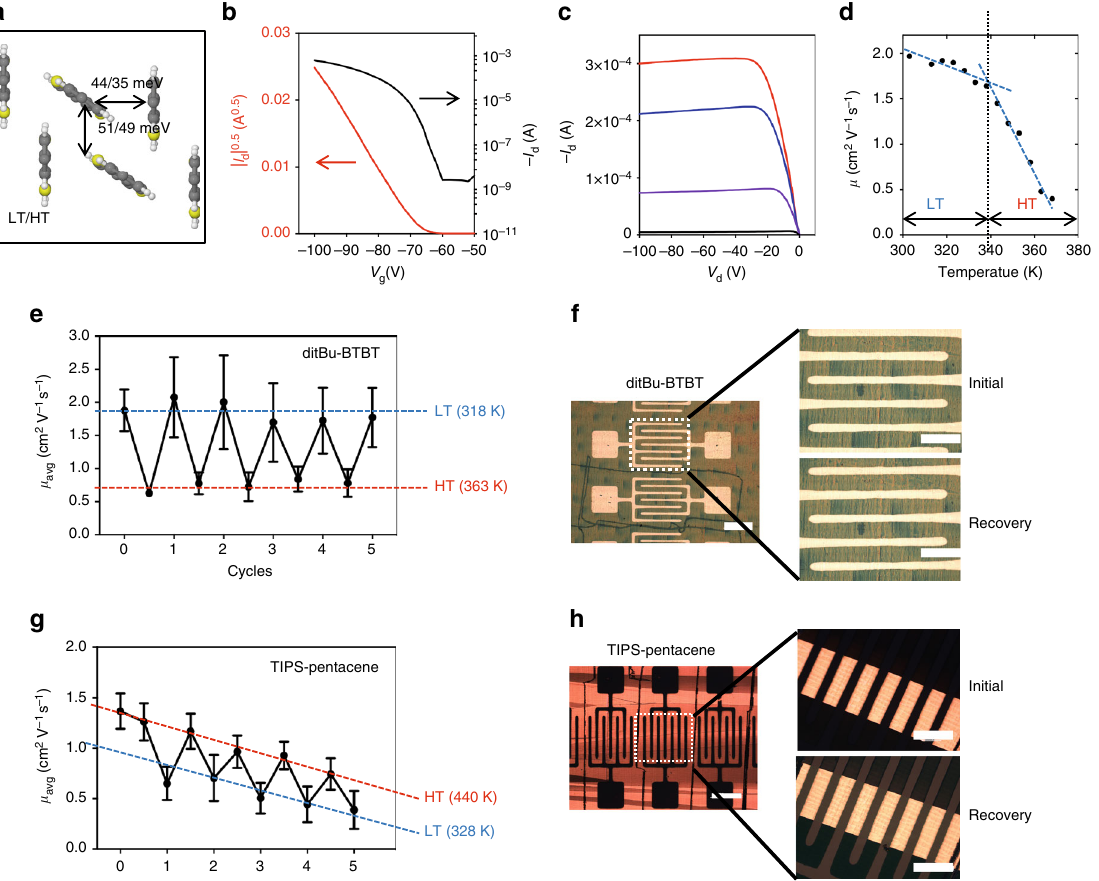
Fig. 6 Electronic properties and function memory effect of thin fi lm transistors. a Calculated charge transfer integrals in the LT and HT forms of ditBu-BTBT. b Transfer curve in the saturation regime ( V d = − 100 V), c output curve and d temperature-dependent apparent mobility in the saturation regime for ditBu- BTBT OFETs. The dashed line indicates the transition temperature at the intersection of the two slopes. Data points are in 5 K increments e Reversible switching of apparent mobility of ditBu-BTBT thin fi lm devices over fi ve thermal cycles. Each mobility value is an average of four devices. Each error bar is calculated from the standard deviation of four devices. f Preservation of thin fi lm morphology and device structure before and after a thermal cycle in ditBu-BTBT. Scale bar on the left corresponds to 500 µ m, and the scale bars on the zoomed in images correspond to 100 µ m. g Reversible switching of apparent mobility of TIPS-pentacene thin fi lm devices over fi ve thermal cycles. Each mobility value is an average of four devices. Each error bar is calculated from the standard deviation of four devices. h Preservation of thin fi lm morphology and device structure before and after a thermal cycle in TIPS-pentacene. Scale bar on the left corresponds to 500 µ m, and the scale bars on the zoomed in images correspond to 100 µ